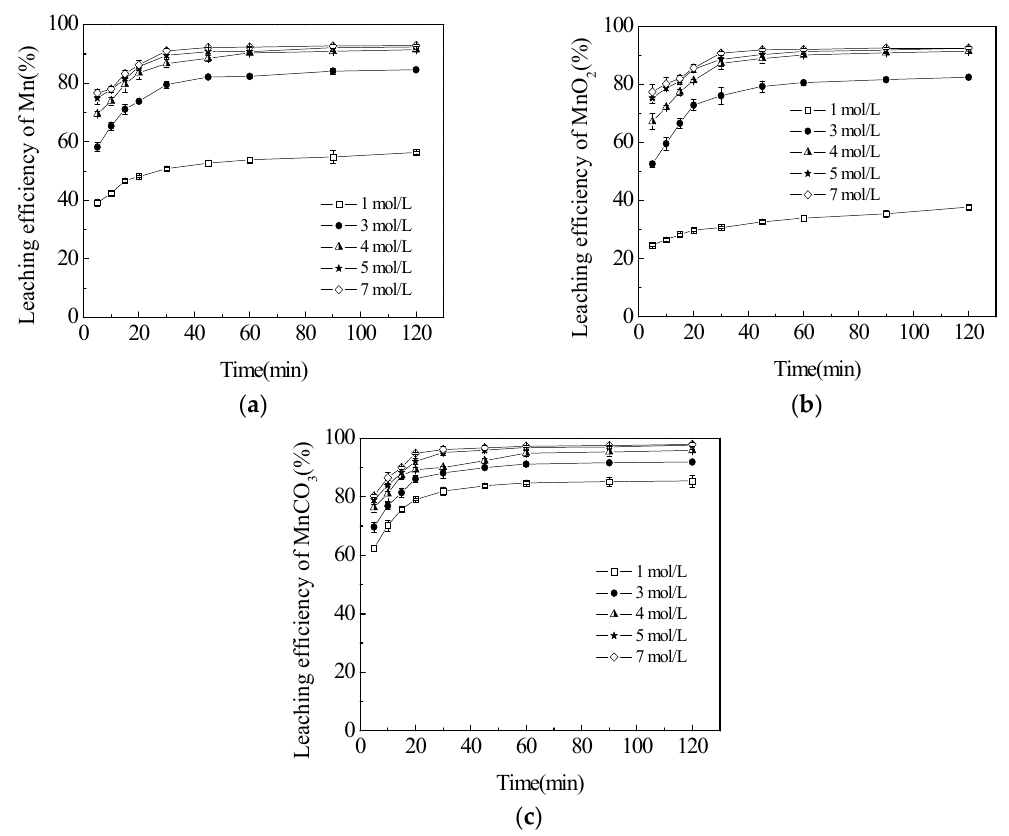
Figure 4. Effect of H 2 SO 4 concentration on the leaching efficiencies of TMn ( a ); MnO 2 ( b ); and MnCO 3 ( c ) in semi-oxidized manganese ore. The data points represent the average values from the triplicate experiments and the error bars represent the 95% Cls.